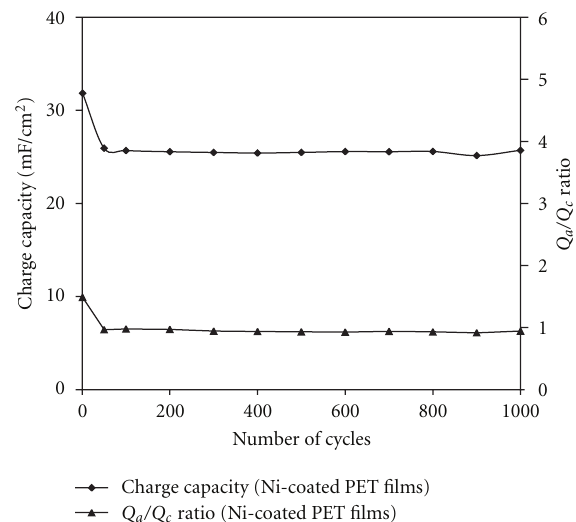
Figure 8: Charge capacity and cycling reversibility of self-assembled MnO 2 thin films as a function of cycle numbers.